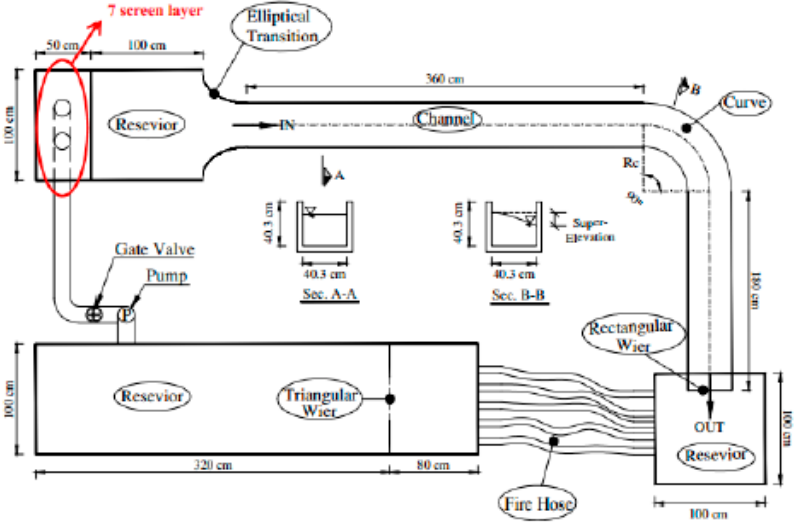
Figure 8. Characteristics of geometrical setup (Gholami et al., 2014) [52]